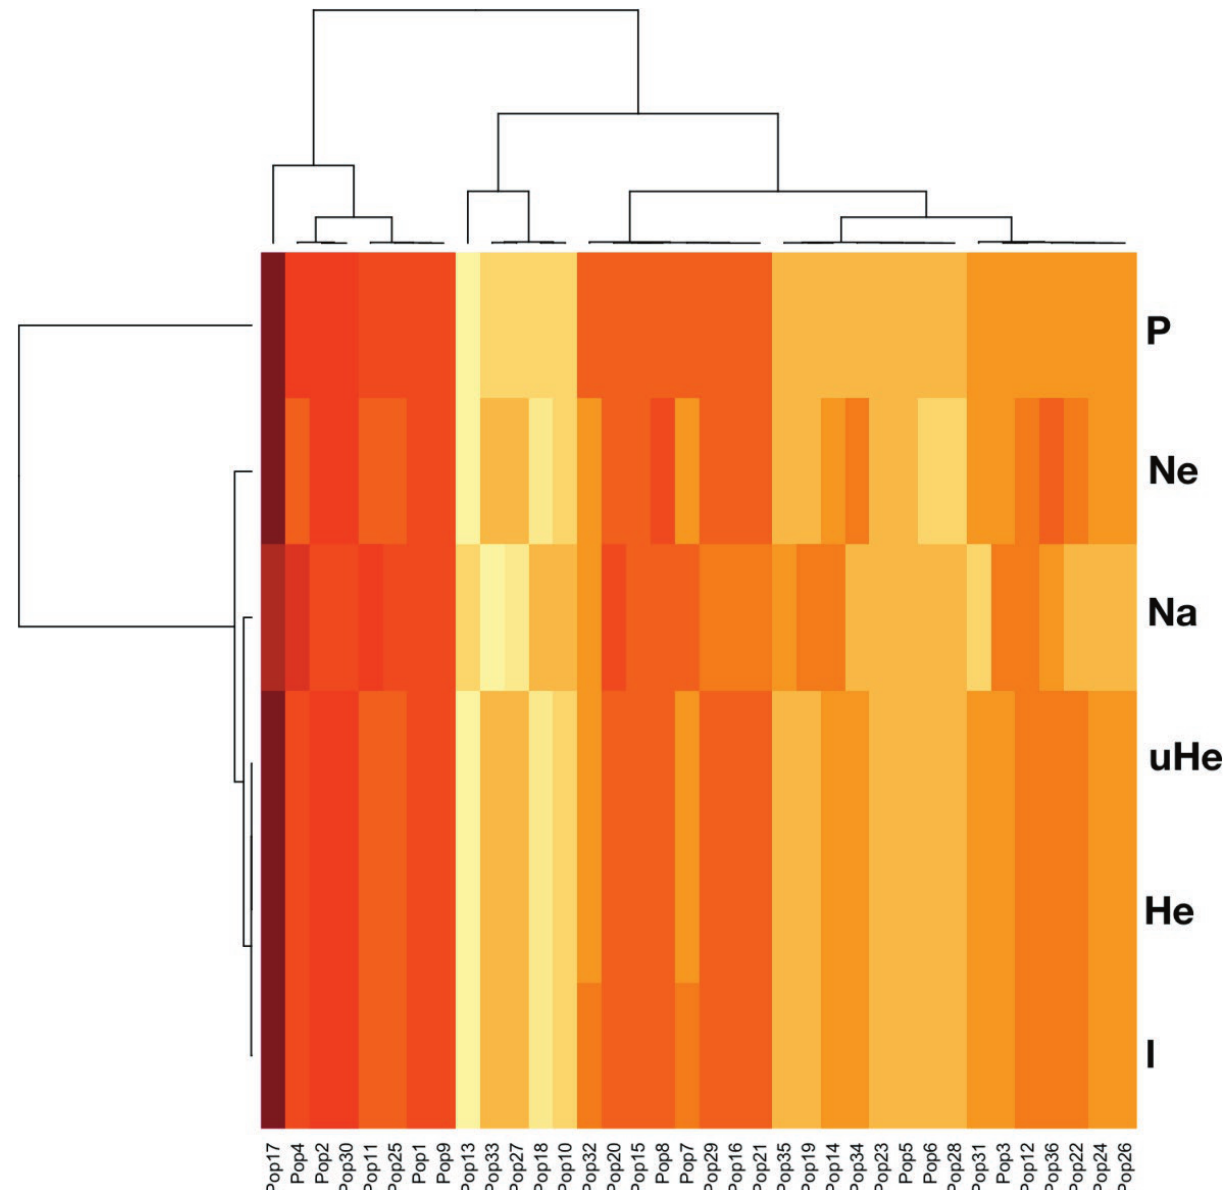
Figure 3. Heatmap of date palm cultivars based on genetic diversity parameters. Abbreviations: Na = No. of different alleles, Ne = No. of Effective alleles, I = Shanon Information. index, He = Expected Heterozygosity, uHe = Unbiassed Expected Heterozygosity, and P% = Poly- morphism